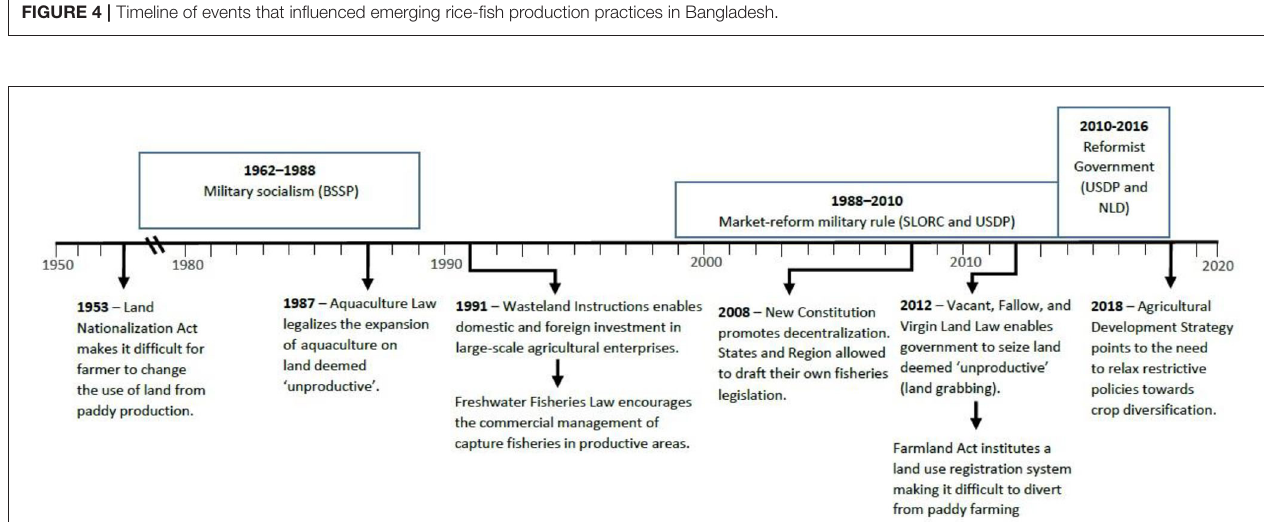
FIGURE 4 | Timeline of events that influenced emerging rice-fish production practices in Bangladesh.